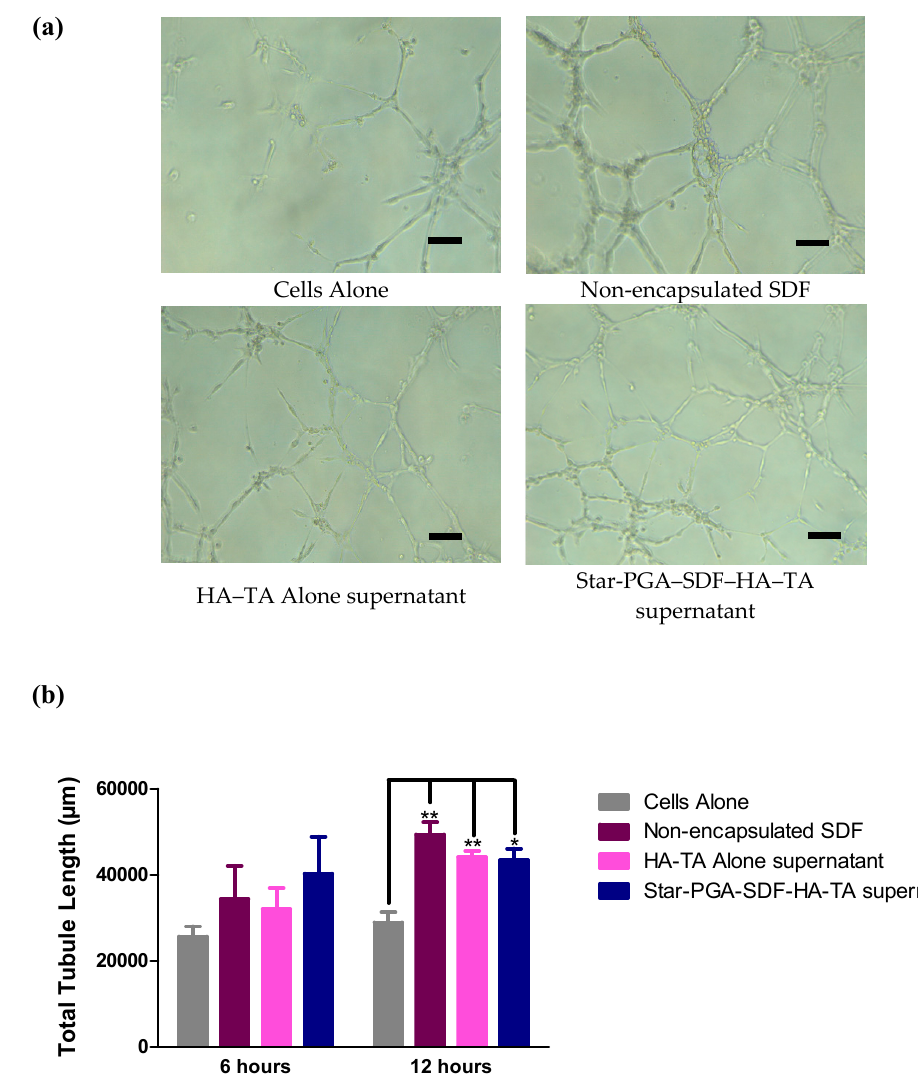
Figure 8. Bioactivity of Stromal-Derived Factor 1 α (SDF) released from star-poly(glutamic acid) (PGA)–SDF(50:1)-HA–TA formulation measured on a Matrigel ® assay. The total length of the tubule network induced by the released SDF is compared to the network formed by untreated cells (cells alone), fresh, non-encapsulated SDF and supernatant from the hydrogel not loaded with SDF nanoparticles. ( a ) Tubules formed at 12 h in the presence of the treatments listed, showing the lowest amount of microvessel formation in the cells alone group. Scale bar = 100 µm ( b ) Quantification of total tubule length on the Matrigel ® assays of samples treated withnon-encapsulated SDF, HA–TA alone supernatant and star-PGA–SDF(50:1)-HA–TA supernatant demonstrated significantly improved total length at 12 h ( n = 3). SDF concentration in all cases is 4.1 ng/mL. * p < 0.05, ** p < 0.01..